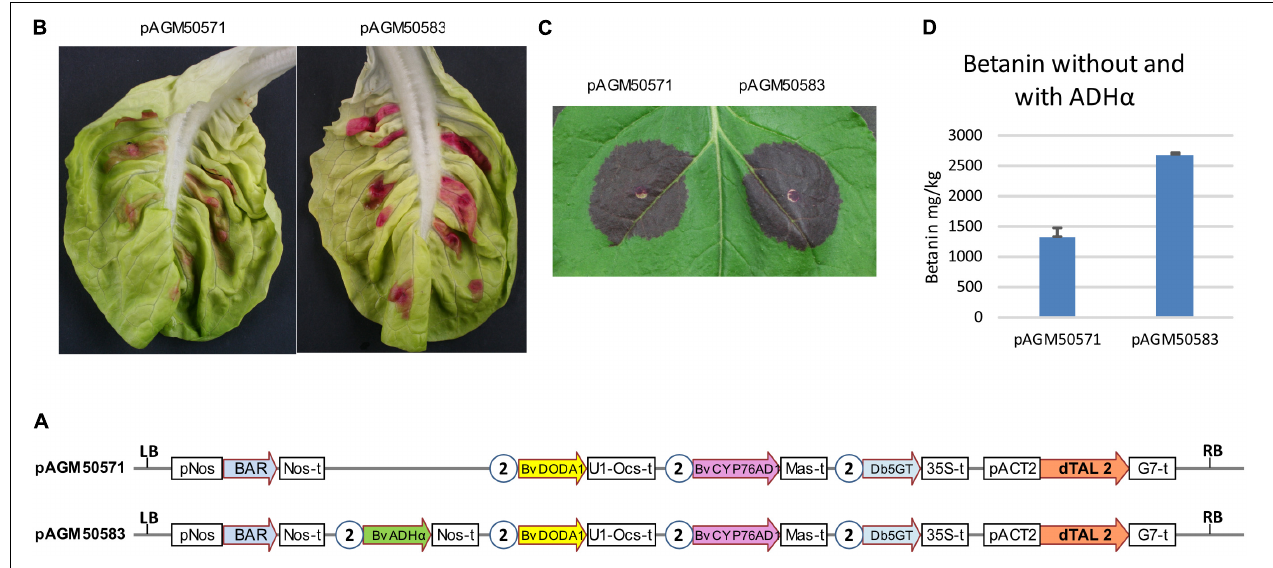
FIGURE 4 | Transient expression of dTALE constructs without or with ADH α . (A) Structure of the constructs infiltrated in leaves shown in (B,C) . pAGM50571 differs from pAGM50583 by the presence of the ADH α coding sequence in pAGM50583. Same legend as in Figure 3 . (B,C) Transient infiltration in lettuce (B) and N. benthamiana leaves (C) . Pictures taken 5 days after infiltration. (D) Quantification of betanin in the N. benthamiana leaf shown in (C)